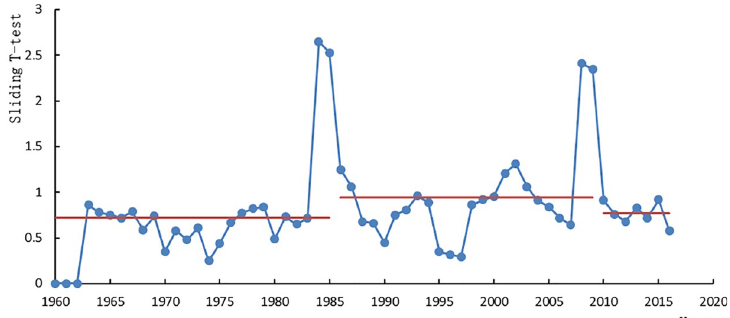
Fig 4. Sliding T-test of annual sediment discharge at Wu Long